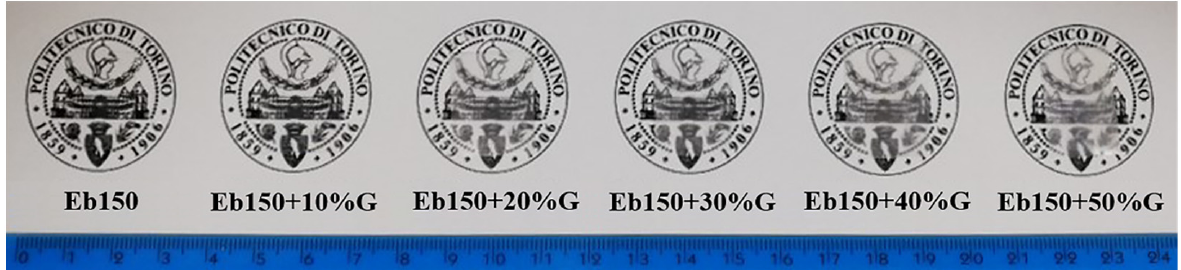
Figure 7. Pictures of UV-LED cured films prepared with different loadings of phosphate glass particles.